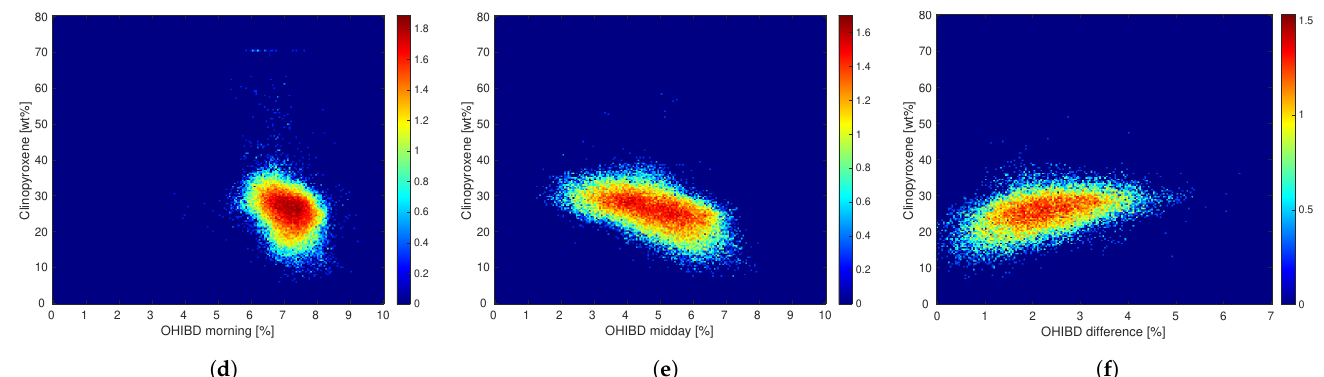
Figure A5. Density plots for the clinopyroxene weight percentage from Lemelin et al. [58] plotted against the OHIBD values at different times of day. The comparison is carried out in the equa- torial mare and highland regions on the lunar near-side. The color bar represents the decadal logarithm of the number of examples at a discrete pixel in parameter space. ( a ) Highland morn- ing ( r = − 0.345), ( b ) Highland midday ( r = − 0.455), ( c ) Highland difference ( r = 0.235), ( d ) Mare morning ( r = − 0.217), ( e ) Mare midday ( r = − 0.500), ( f ) Mare difference ( r = 0.372).